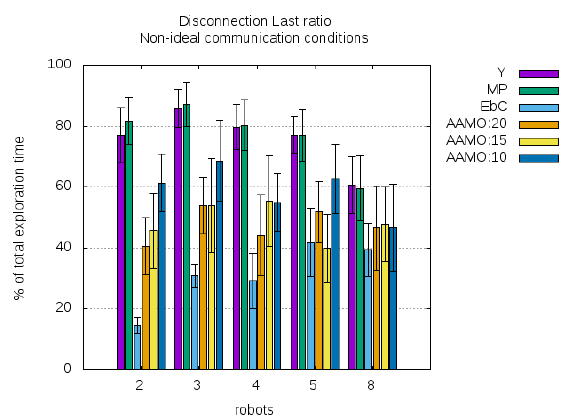
Figure 25. Disconnection Last Ratio (DLR) under non-ideal communication conditions. The bigger the HO-Threshold , the smaller DLR. This fact holds showing an oscillatory behaviour as the fleet size